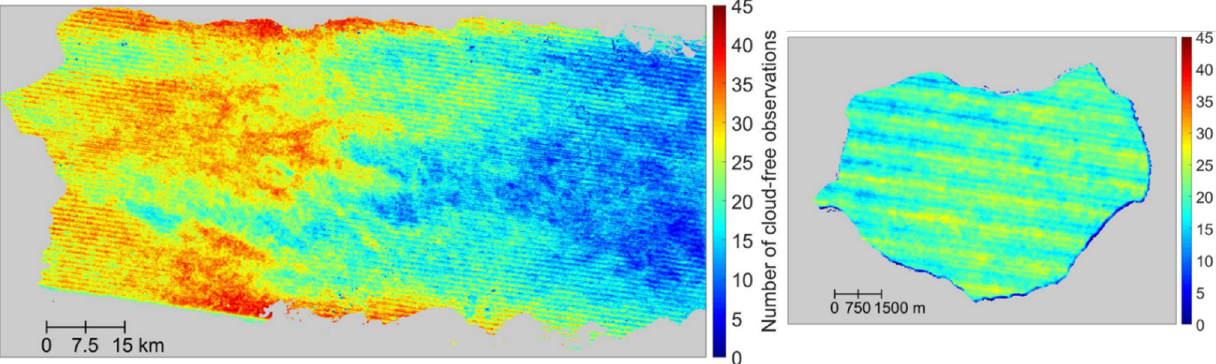
Figure 5. Number of cloud-free Landsat 7 ETM+ observations in the western part of the main island ( left ) and Mona ( right ) from the years 2005–2009. Pixels with fewer than 10 cloud-free observations are in wetter forest areas in the east, and at the highest elevations (600 to 1300 m).